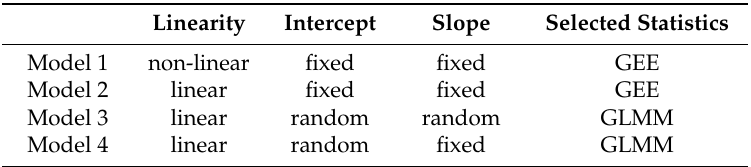
Table 2. Models for generalized estimating equation (GEE) and generalized linear mixed model (GLMM) analyses.